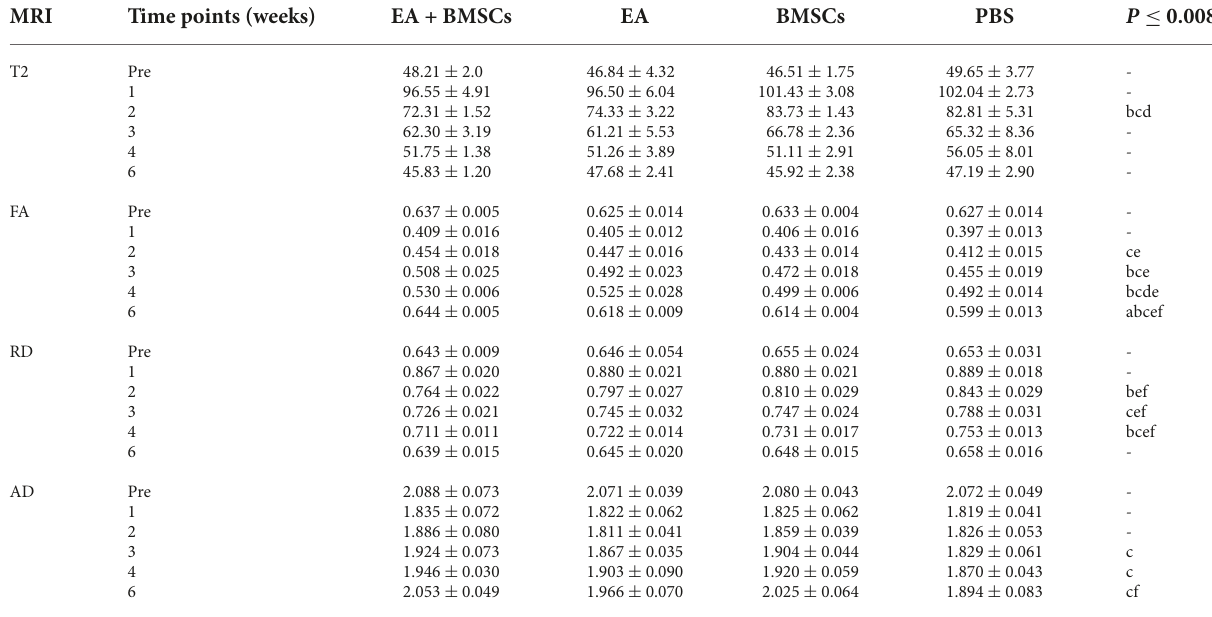
TABLE 2 MRI values in EA + BMSCs, EA, BMSCs, and PBS (mean ± SD).